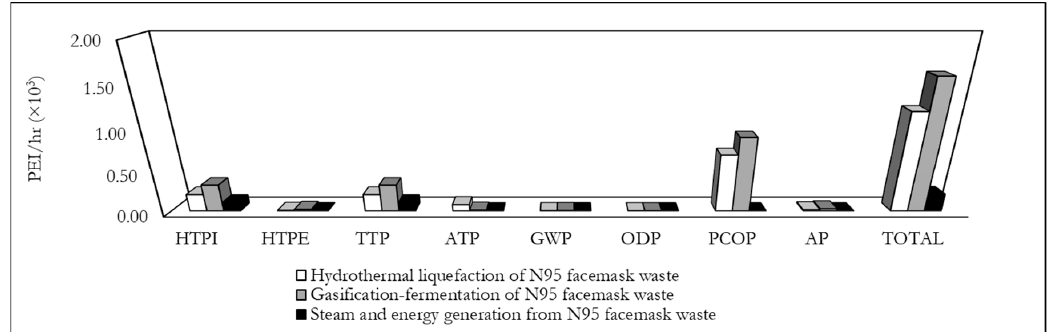
Figure 6. The comparative assessment of the potential environmental impacts of hydrothermal liquefaction (HTL) of waste N95 facemask, gasification–fermentation of waste N95 facemask and steam and energy generation from waste N95 facemask production processes. HTPI denotes the ingestion impact category, HTPE denotes inhalation / dermal impact category, TTP denotes terrestrial